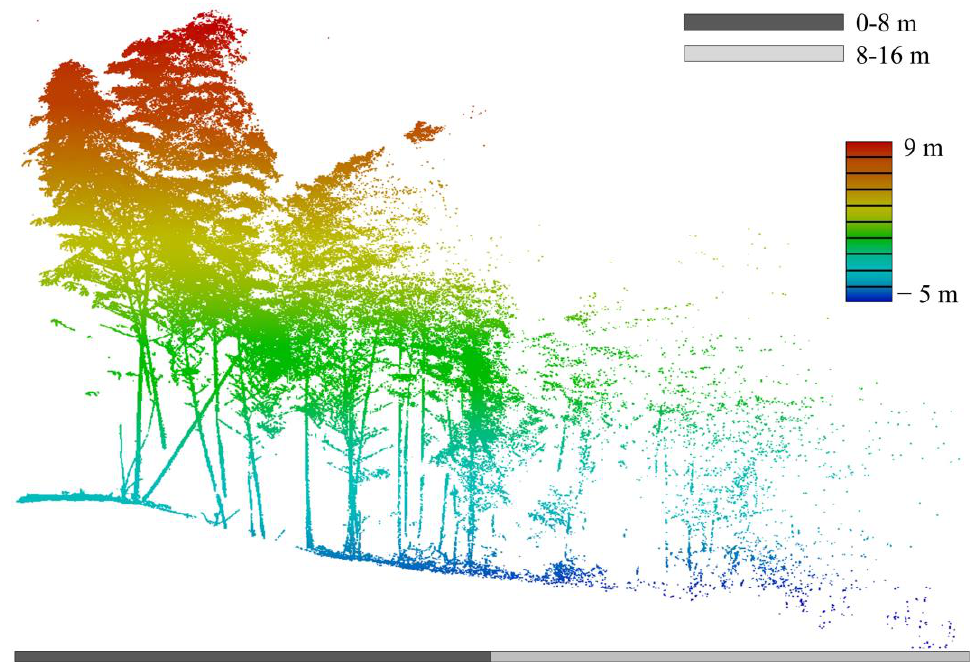
Figure 9. A slice of original point clouds. Left side is near to the